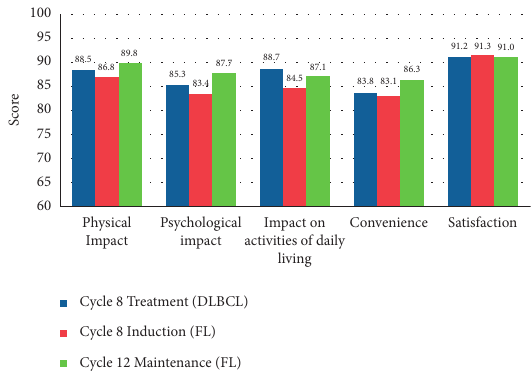
Figure 2: Rituximab Administration Satisfaction Questionnaire: results at cycle 8 treatment (DLBCL patients), cycle 8 induction, and cycle 12 maintenance (FL patients). Labels are mean